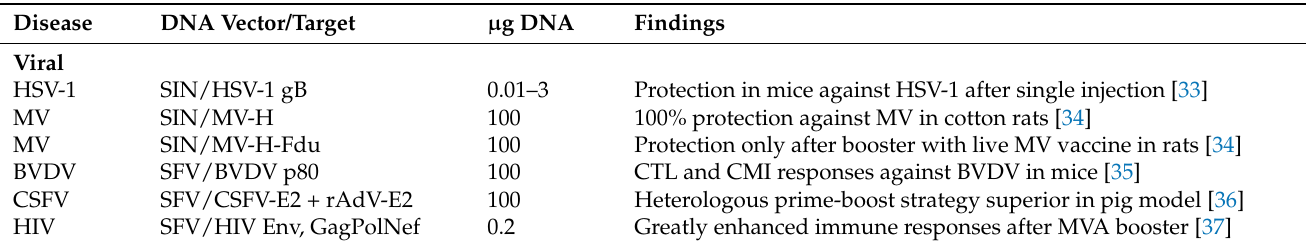
Table 1. Examples of DNA replicon-based vaccines against infectious agents and toxins. Disease DNA Vector/Target µ g